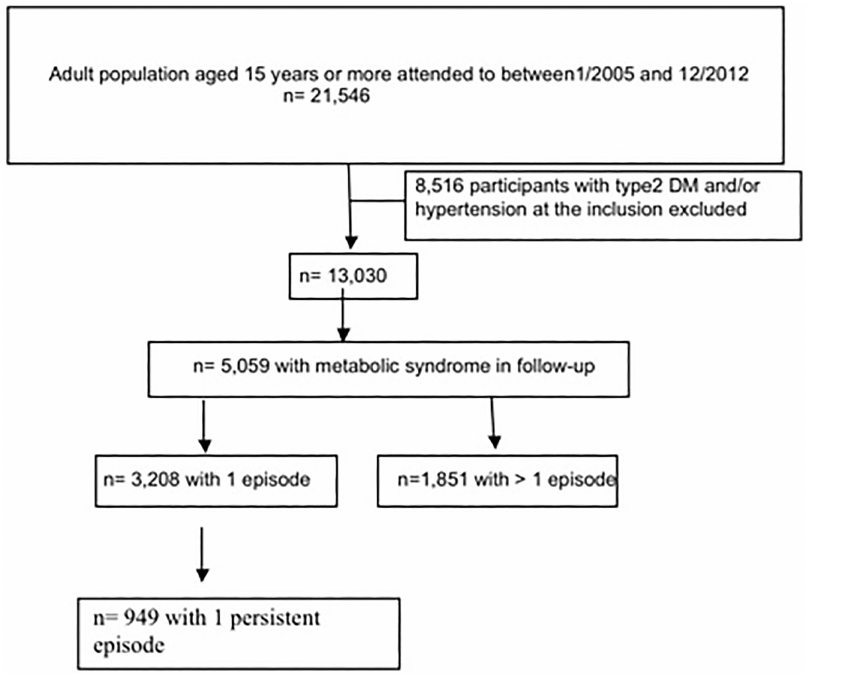
Fig 1. Flow-chart of cohort